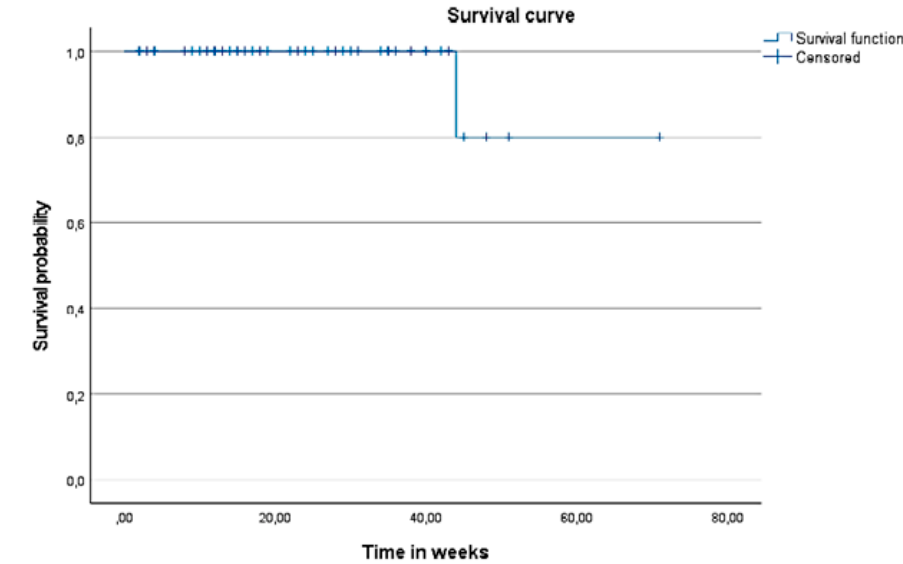
Figure 6. The Kaplan–Meier survival curve after surgery.